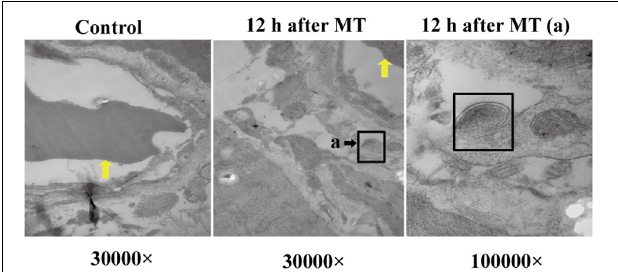
FIGURE 7 | Bacterial structure near the capillary wall. The yellow arrow referred to the red cell. The black square referred to cross section structure of bacteria which has a double layer membrane structure. (a) Enlarged picture under the same vision at 12 h after MT (100,000 × ).